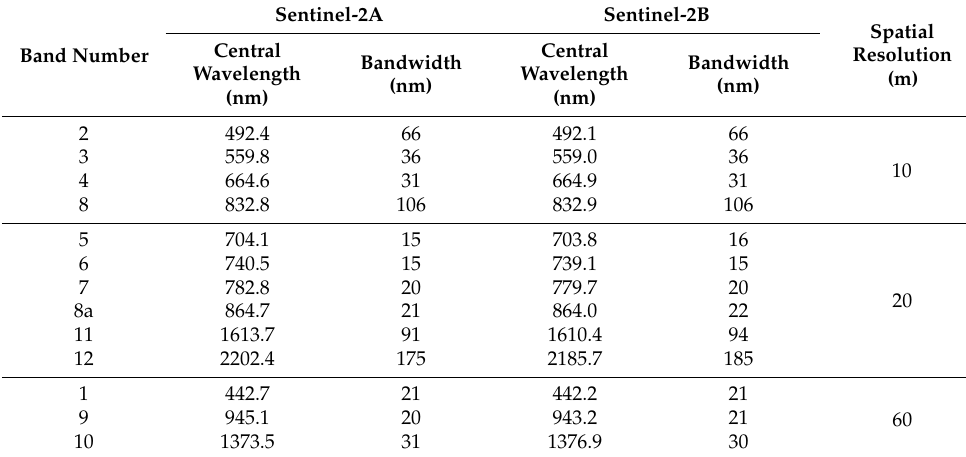
Table 3. Characteristics of Sentinel-2 satellite images used in the study [55].